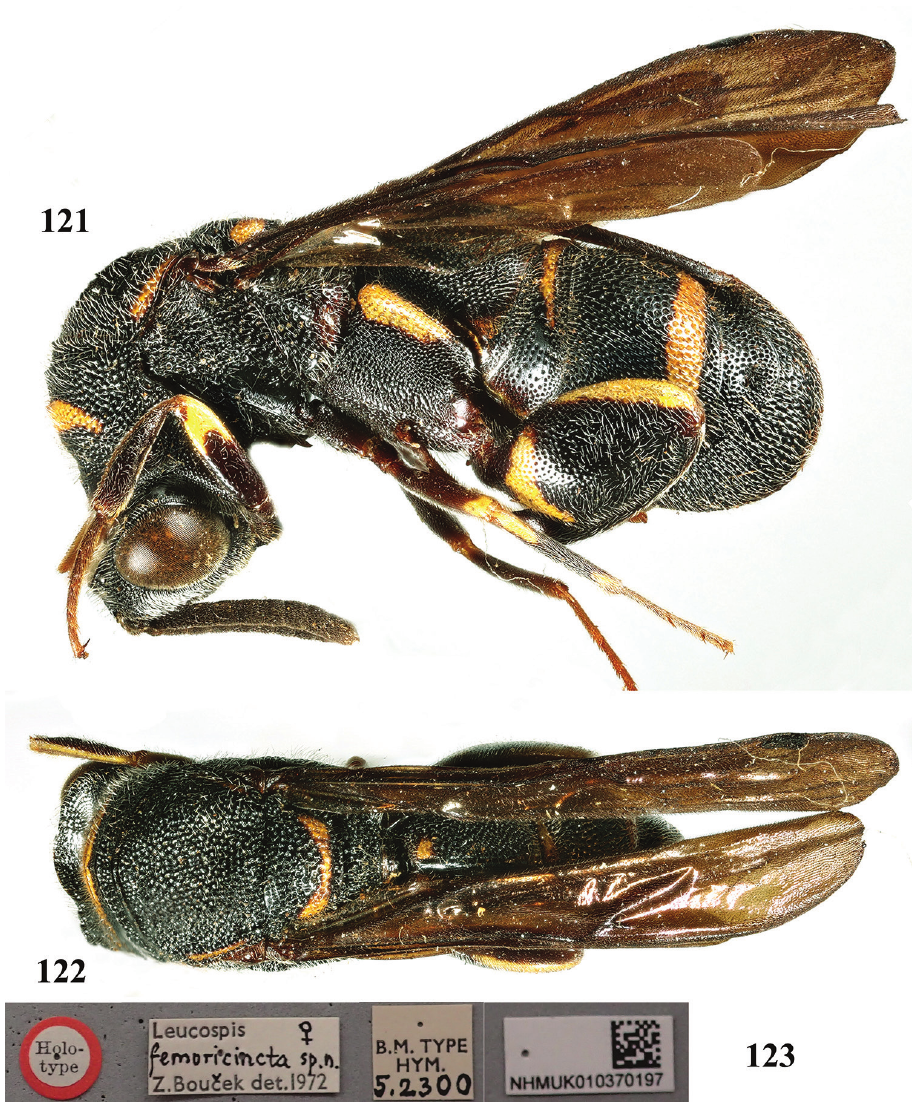
Figures 121–123. Leucospis femoricincta Bouček, ♀ , holotype. 121 Habitus lateral 122 habitus dorsal 123 labels (courtesy of Dr. Natalie Dale-Skey Papilloud, The trustees of the Natural History Museum, London,